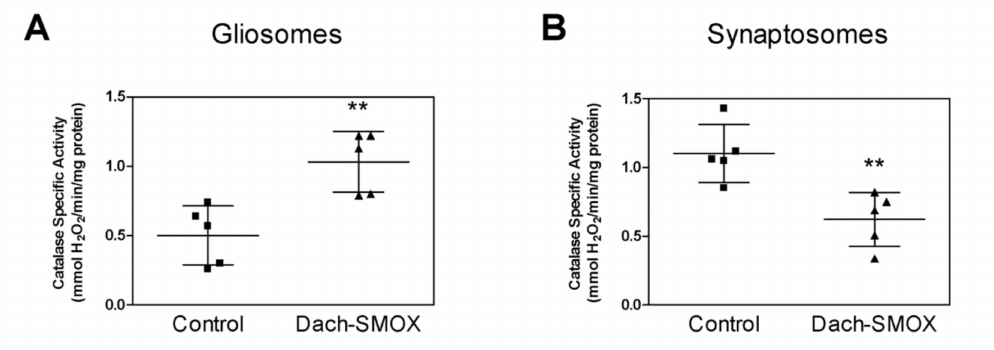
Figure 5. Analysis of catalase activity in Dach-SMOX cerebrocortical gliosomes and synaptosomes. The specific activity of catalase (mmoles of decomposed H 2 O 2 per min per mg protein) was quantified by spectrophotometric assay in brain cortex ( A ) gliosomes and ( B ) synaptosome from both control and Dach-SMOX mice. Data are reported as filled squares (control) and filled triangles (Dach-SMOX). Mean and SD of experiments performed in quadruplicate on five animals per group are also reported. ** p ≤ 0.01, according to Mann–Whitney